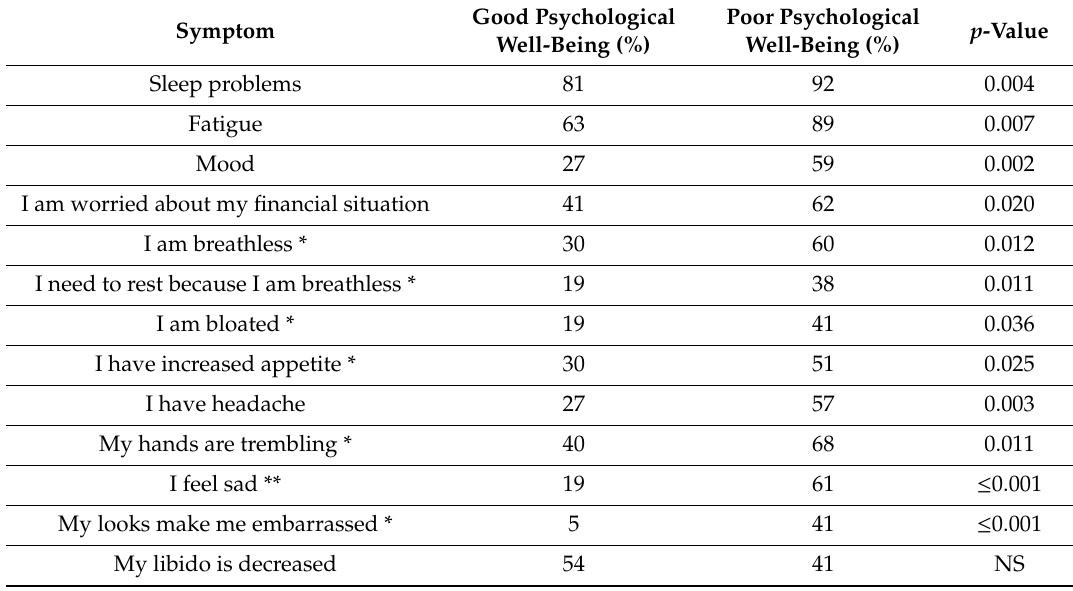
Table 6. Symptom occurrence and di ff erences between heart recipients with good psychological well-being versus poor psychological